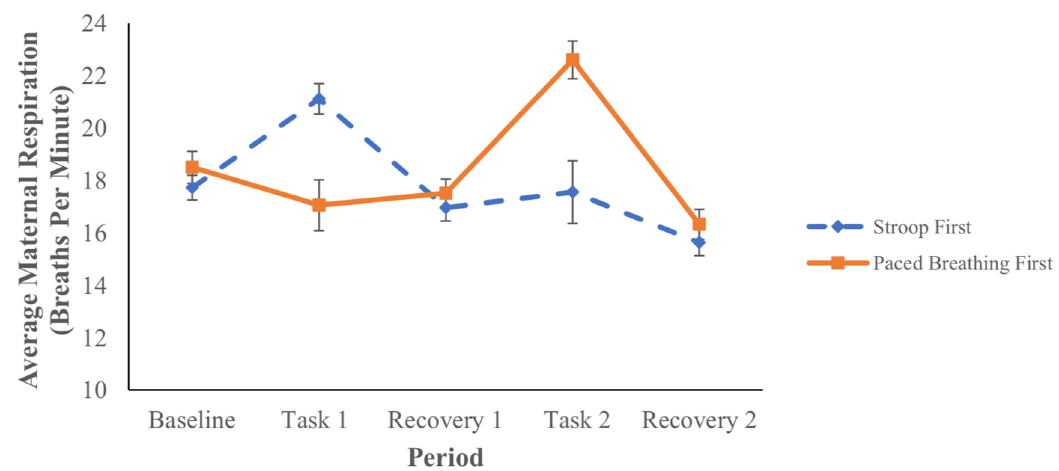
Figure 5. Maternal Respiratory Rate During Each Study Period By Group.